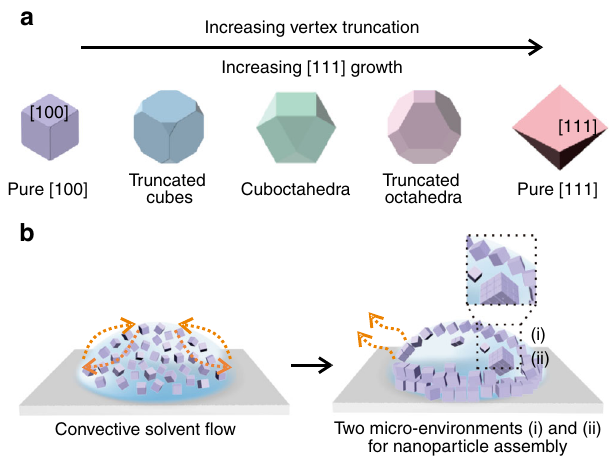
Fig. 1 Dual micro-environments to achieve one assembly with two structures. a Ag polyhedra building blocks range from cubes to octahedra. b A droplet of nanoparticle dispersion is allowed to dry on a substrate. Convective solvent fl ow within the droplet during solvent evaporation concentrates Ag polyhedra near the drying front, giving rise to two unique regions of crystallization (i and